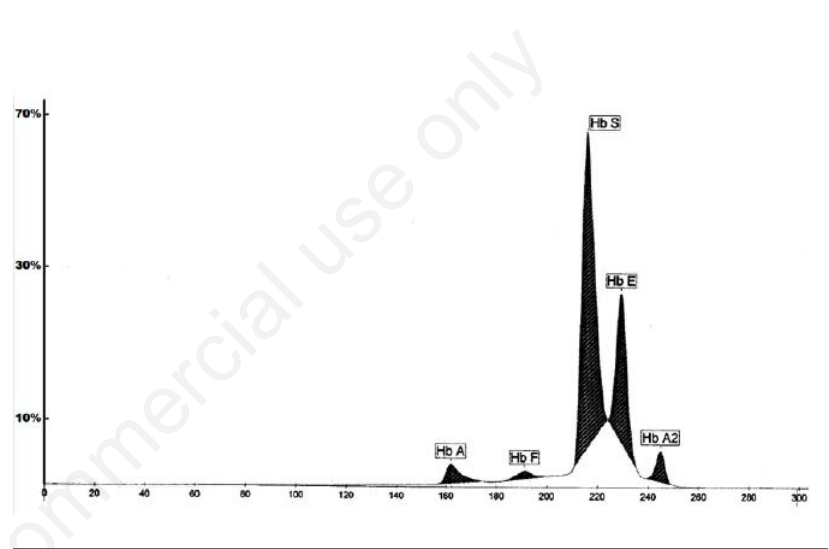
Figure 2. Hemoglobin capillary electrophoresis analysis showing presence of Hb G- Makassar which has properties identical to those Hb S. Where Hb A = 4.6%, Hb F =